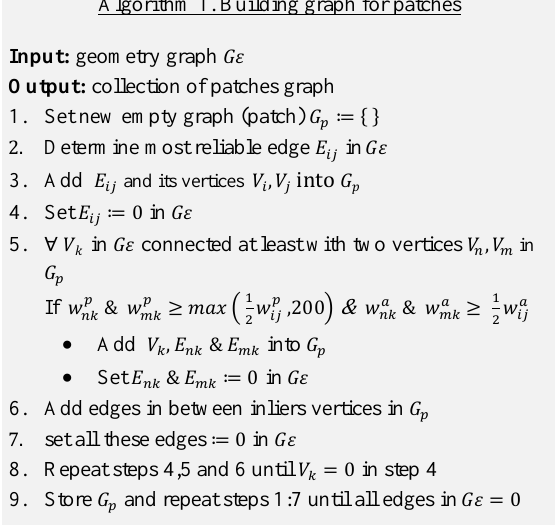
Algorithm 1. Building graph for patches